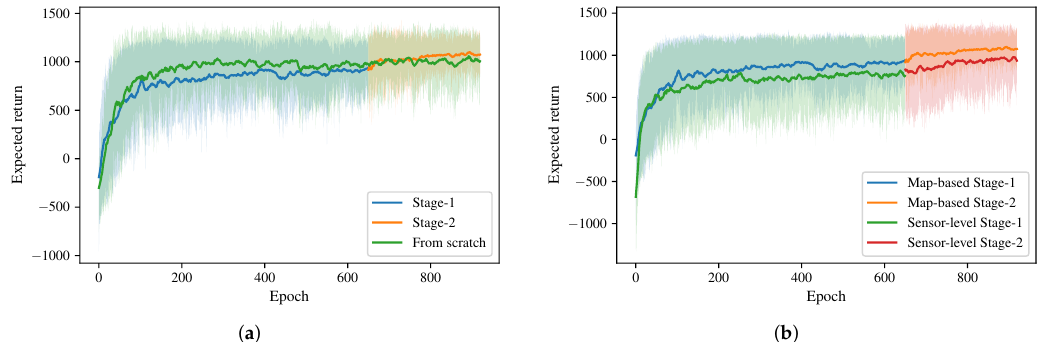
Figure 4. ( a ) Comparison of the expected return shown in epochs for the training process with two-stage curriculum learning and the training process without two-stage curriculum learning, i.e., from scratch. ( b ) Comparison of the expected return shown in epochs for the training process using Map-based policy and the training process using sensor-level